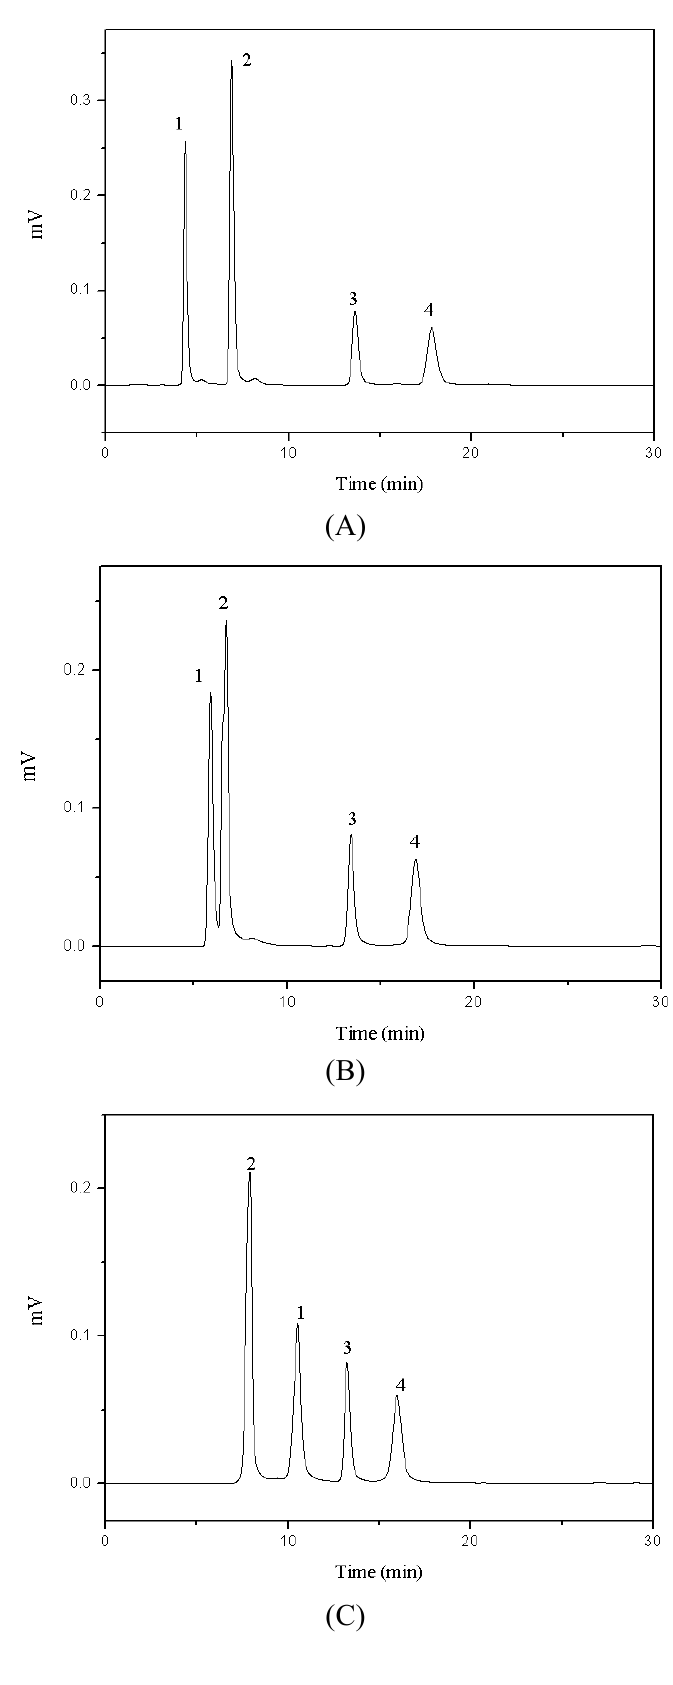
], (B) [HMIM][BF ], (C) [OMIM][BF 4 4 4